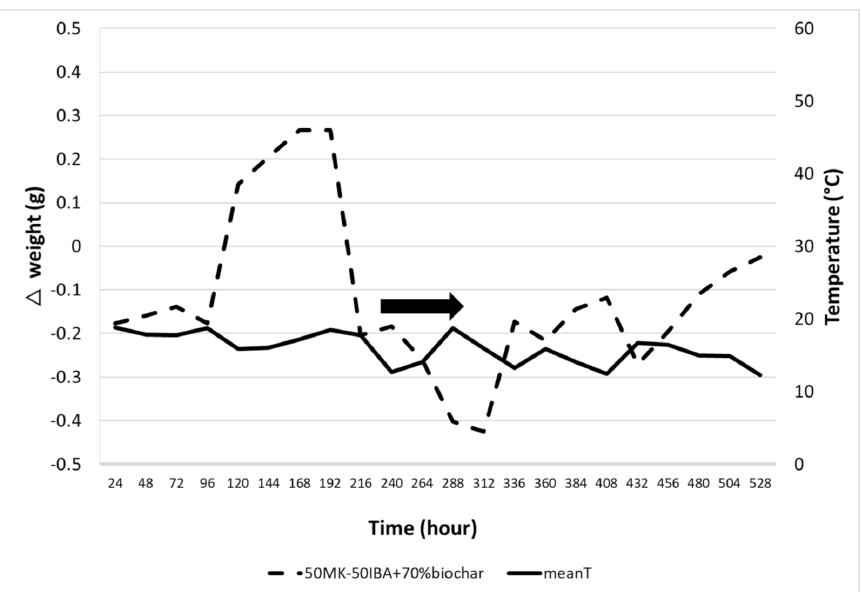
Figure 14. Absorption and release of humidity of MK + 70%biochar samples in an outdoor environ- ment and 50% MK_50% IBA + 70%biochar samples in an outdoor